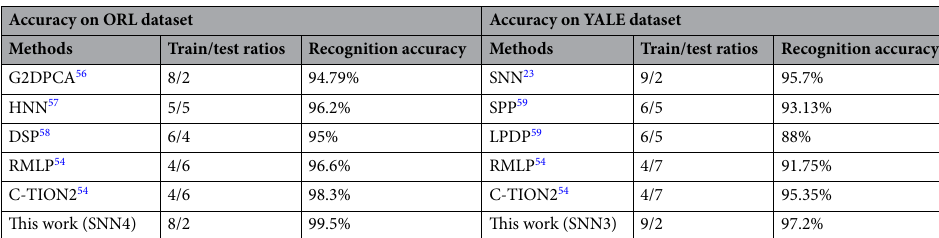
Table 4. Comparison of the performance accuracy of SNN3 and SNN4 on YALE and ORL data set.